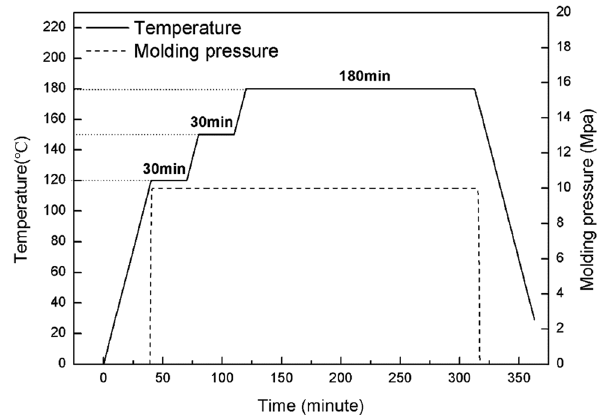
Figure 2: Cure pro fi le for the fabrication